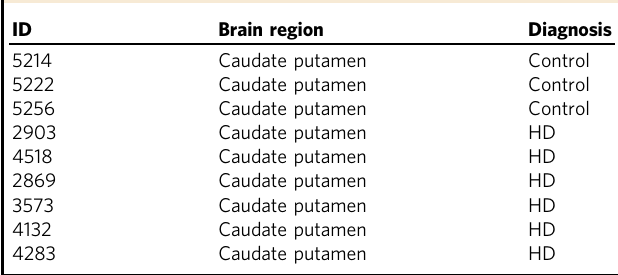
Table 1 HD patient and normal subject postmortem